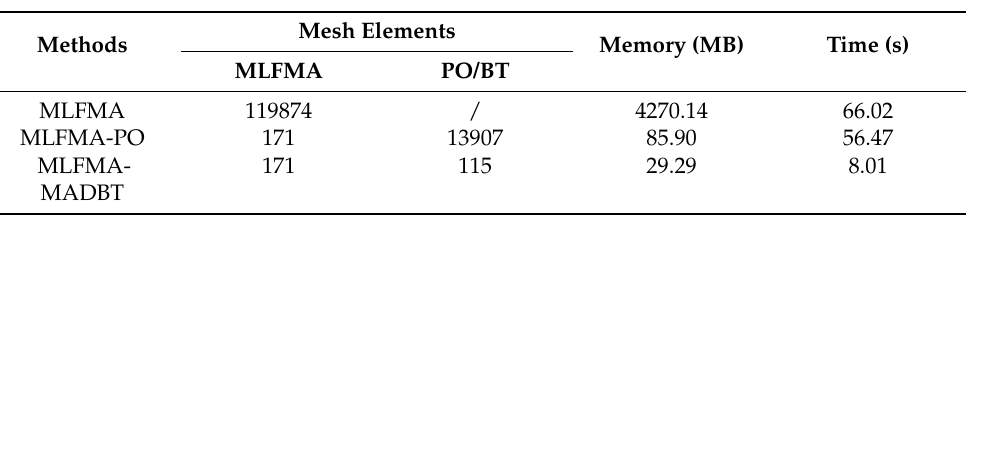
Table 1. Calculation time and memory requirements of different methods for the wire antenna mounted on a trihedral corner